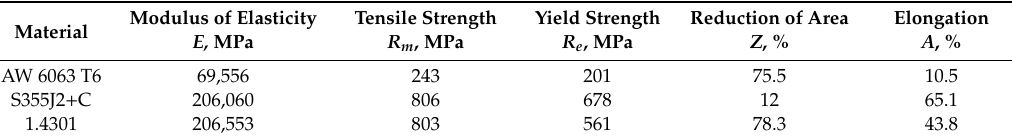
Table 1. Mechanical properties for selected materials.